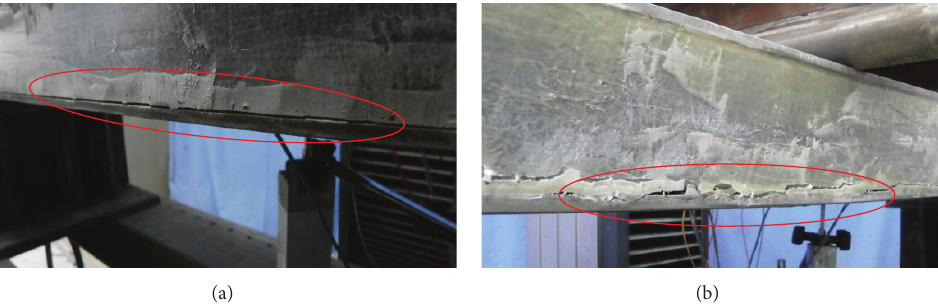
Figure 7: Failure of specimen S( 8 )-GFRP: (a) web peeling off from the lower facesheet and (b) web on the other side delaminating from the lower